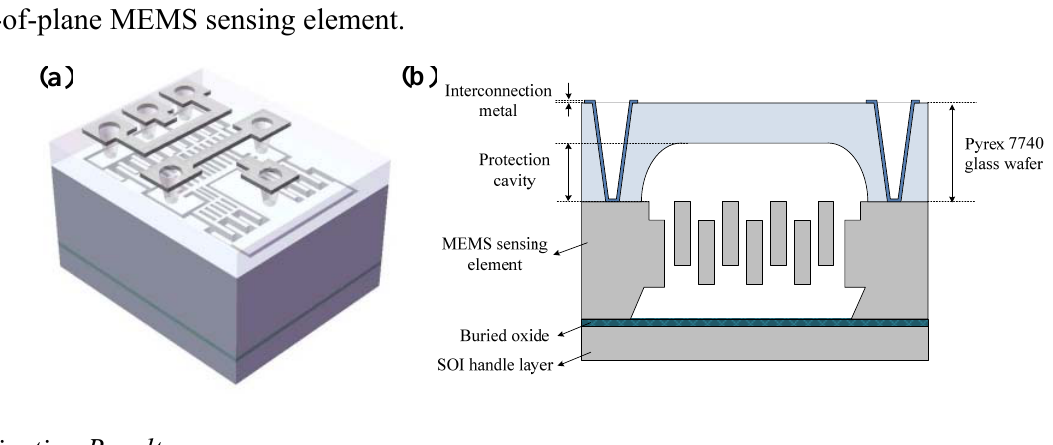
Figure 11. (a) Packaged device. (b) Cross-sectional view. Schematic diagram of packaged out-of-plane MEMS sensing element.